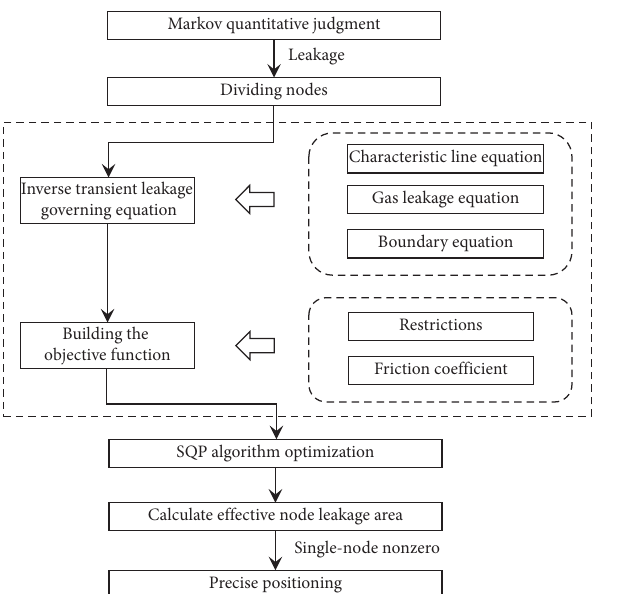
Figure 2: Leak diagnosis analysis model of urban buried non- metallic